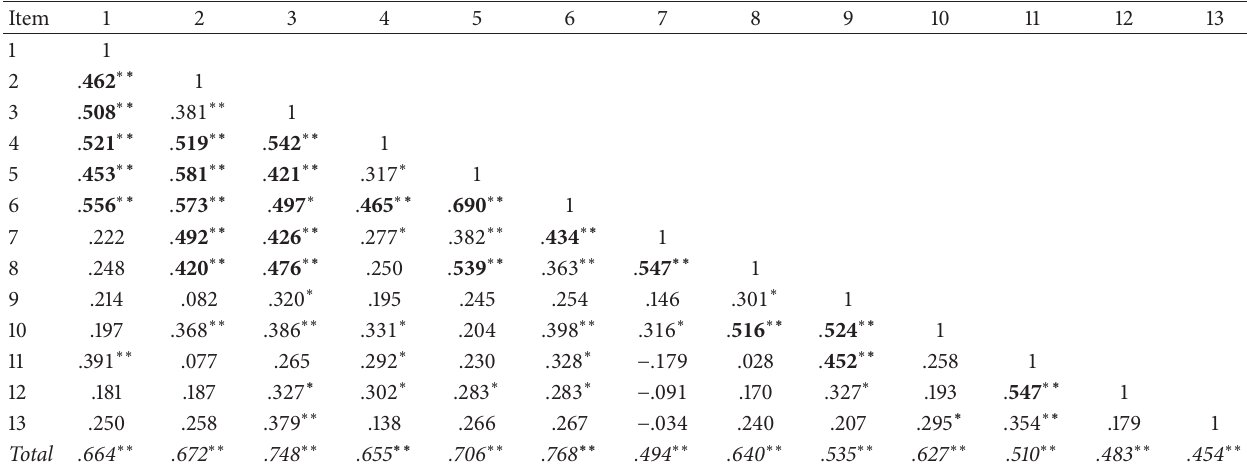
Table 2: BDI-13 interitem correlations.